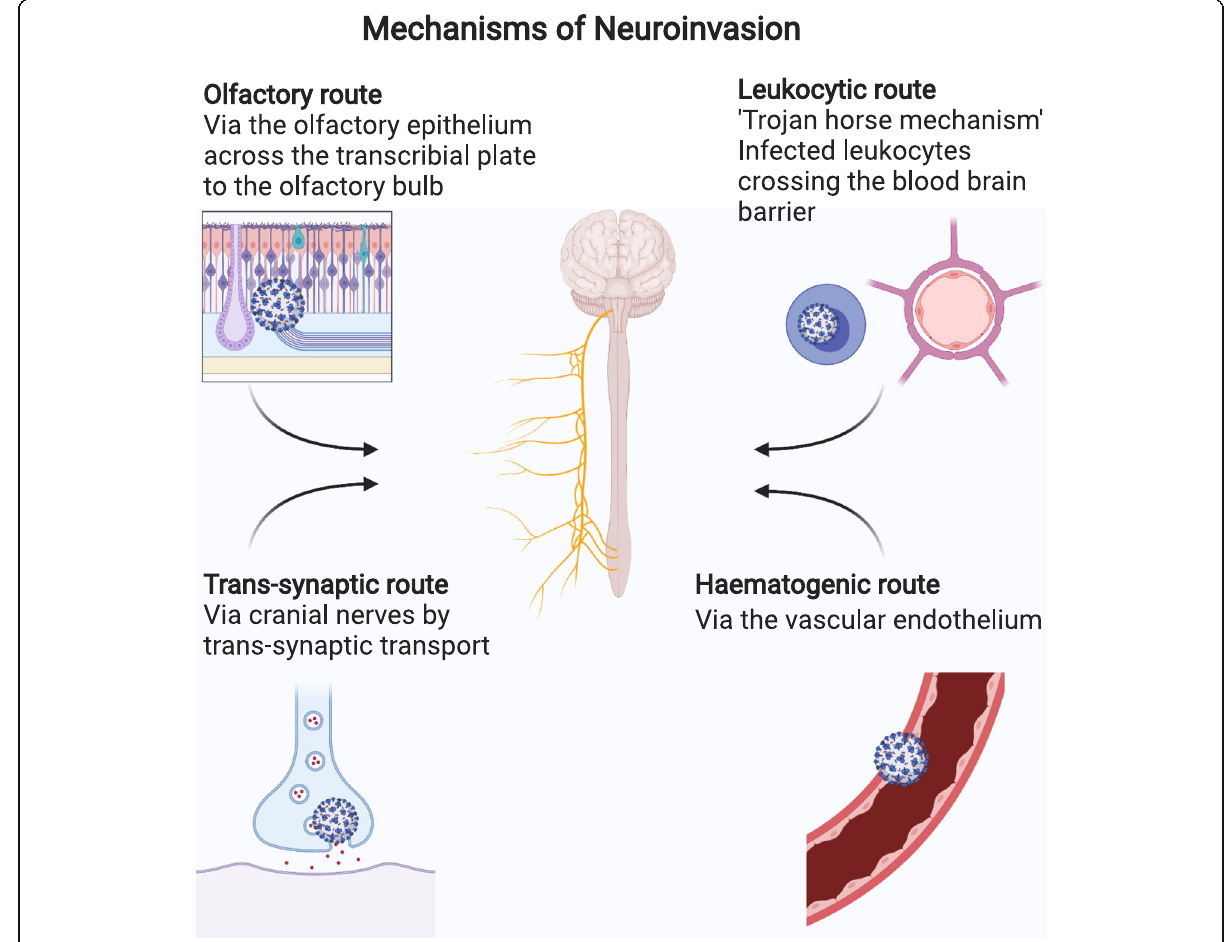
Fig. 1 Mechanisms of Neuroinvasion (Created with